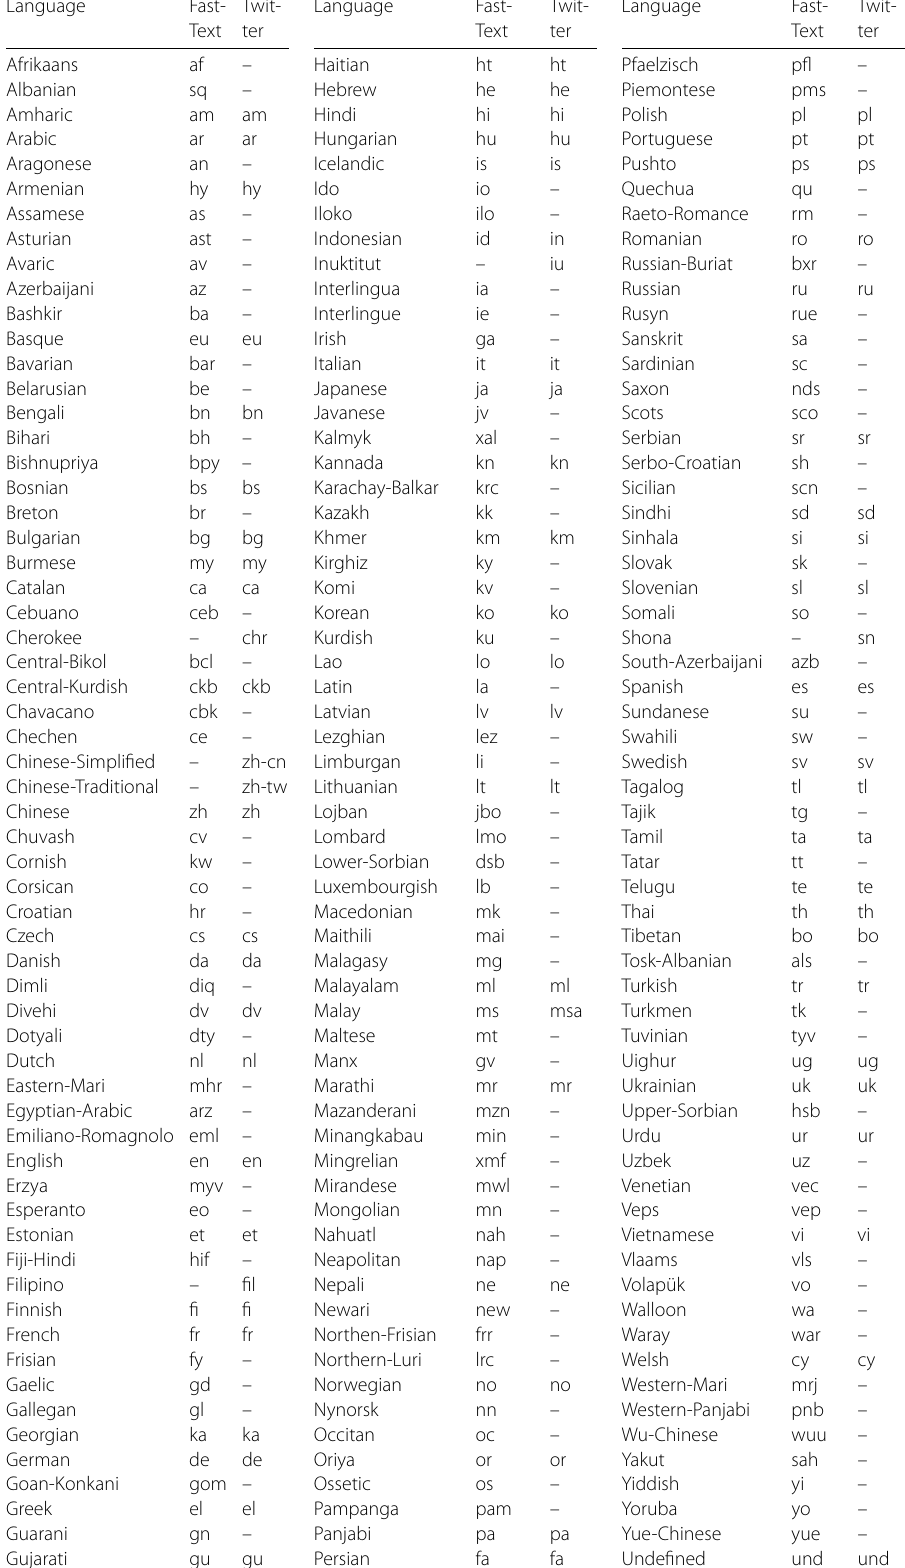
Table 1 Language codes for both FastText-LID and Twitter-LID tools